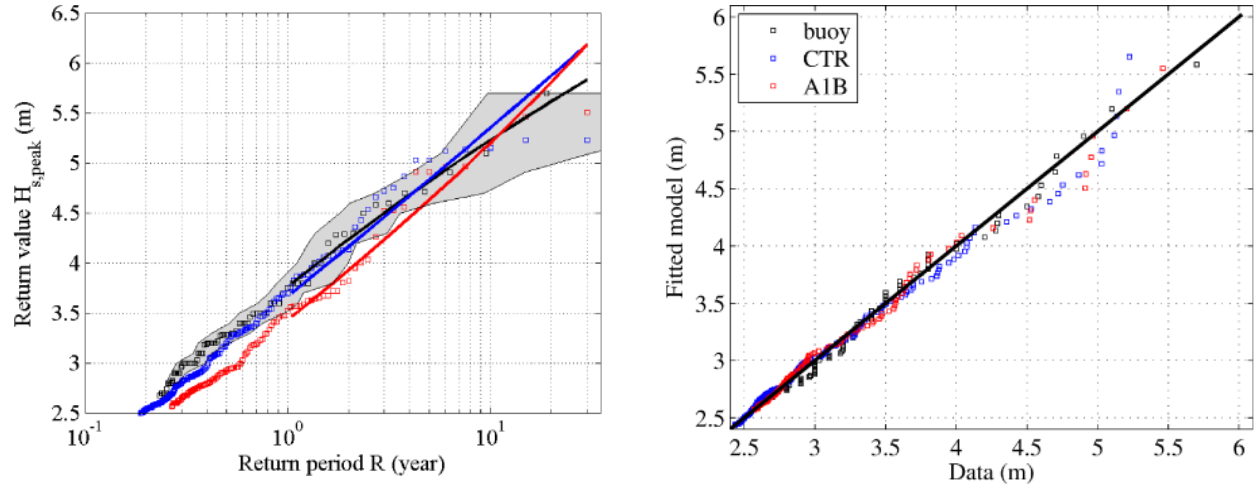
Fig. 4. Return level plot for H s,peak at the Ortona buoy. Empirical data (squares) are the POT values for each dataset (black: observed; blue: CTR run; red: A1B run). The return period is calculated in accordance with Eq. (1), and the observed data confidence interval is bounded by the gray area. Empirical data are compared to the GPD results (solid lines in figure). Table 1. Ortona and Monopoli goodness of fit. Obs: buoy data; CTR and A1B: modeled data. R-square: coefficient of determina- tion; RMSE: root-mean-square error.